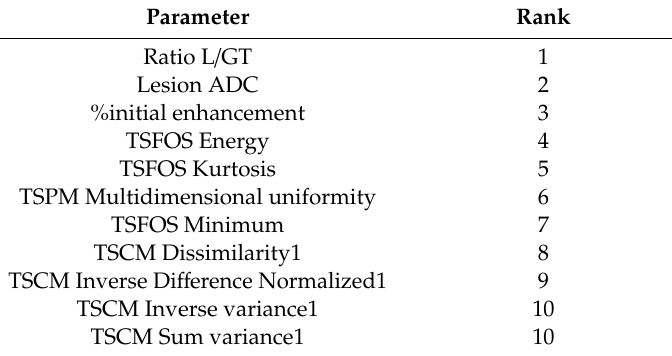
Table 4. The ranking of mpRad features identified by